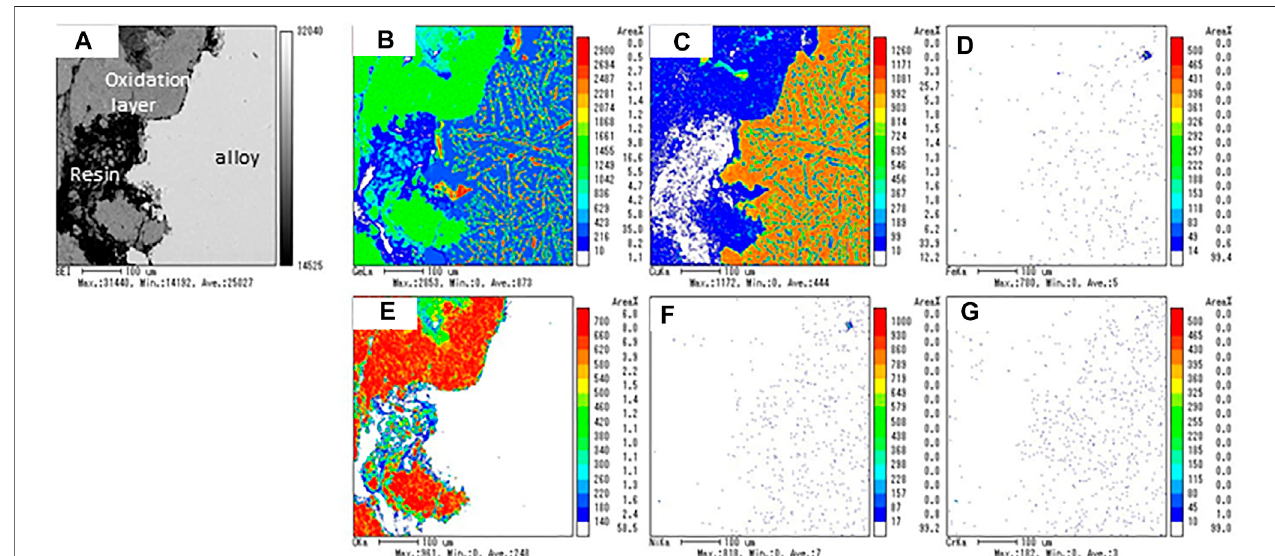
FIGURE 8 | (A) Backscattered electron image (BEI) micrograph and elemental mapping images of (B) Ge, (C) Cu, (D) Fe, (E) O, (F) Ni, and (G) Cr for the sample obtained after the thermal response test in an air stream.